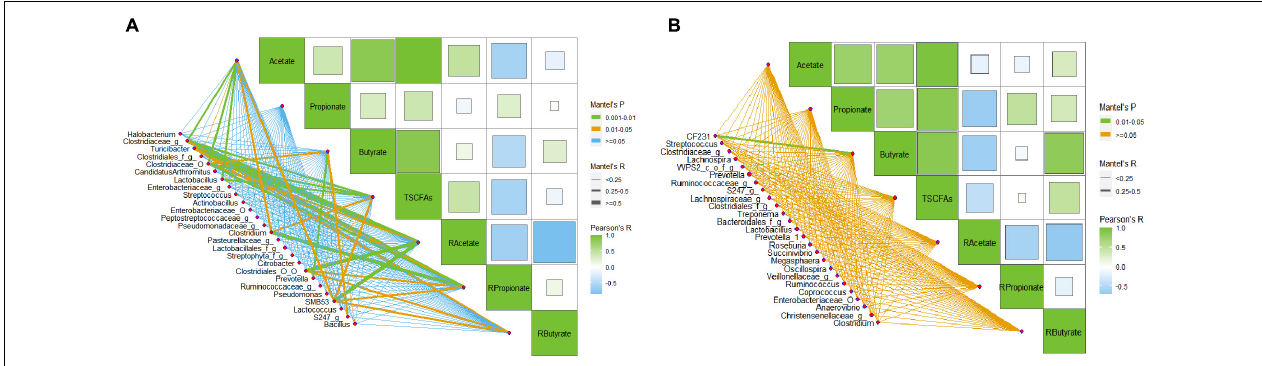
FIGURE 4 | Pearson correlation between the relative abundance of main bacteria and SCFAs in the ileal and colonic digesta of the growing pigs. (A) Correlation between the abundance of main bacteria (top 20 bacterial genera and bacteria with significant difference between groups) and SCFA concentrations and ratios in the ileal digesta of the pigs; (B) correlation between the abundance of main bacteria (top 20 bacterial genera and bacteria with significant difference between groups) and SCFA concentrations and ratios in the colonic digesta of the pigs. The lowercase letters o, f, and g following the Latin names of bacteria mean order, family, and genus,